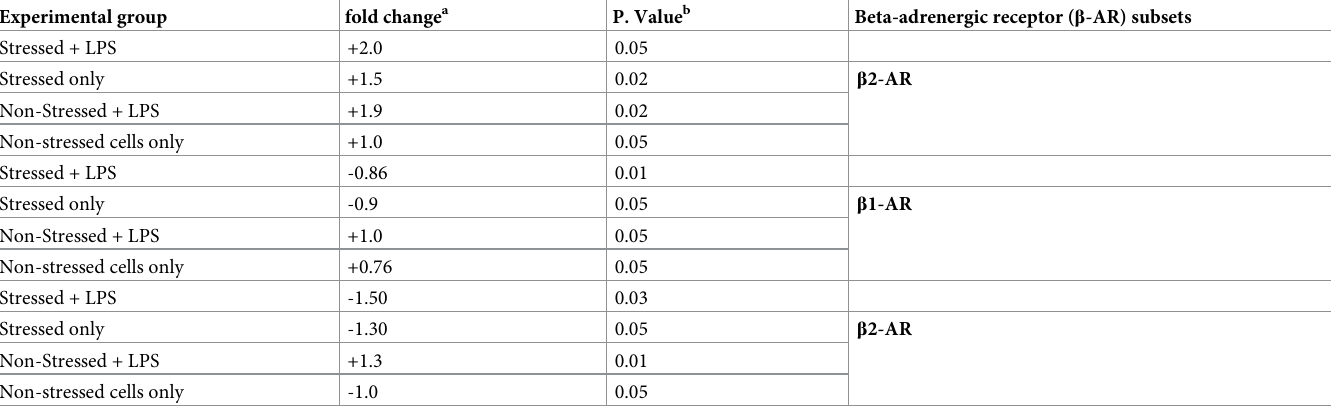
Table 4. Gene expression profiles of β -AR subtypes in BMDCs of stressed and non-stressed